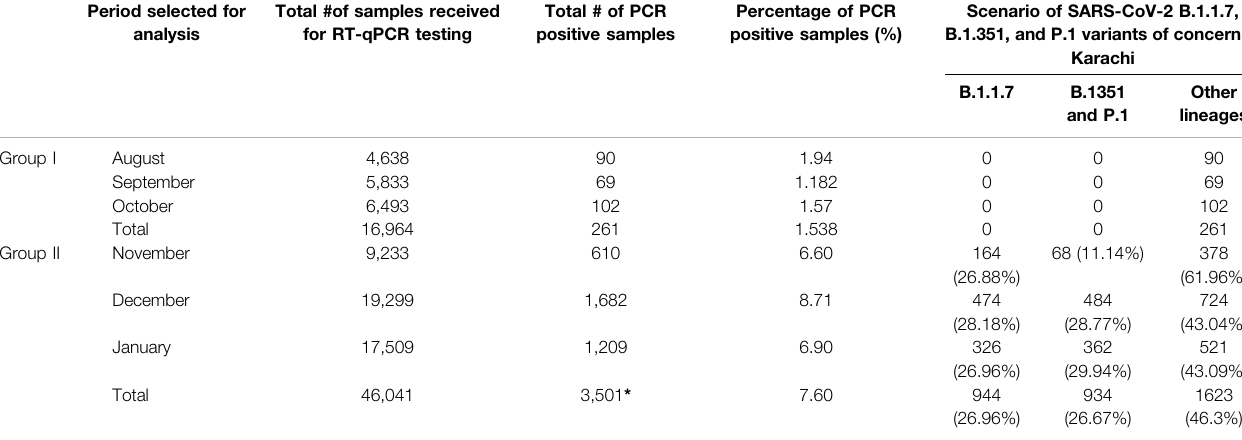
TABLE 2 | Scenario of SARS-CoV-2 B.1.1.7, B.1.351, and P.1 variants of concern in Karachi, Pakistan. Period selected for Total #of samples received analysis for RT-qPCR